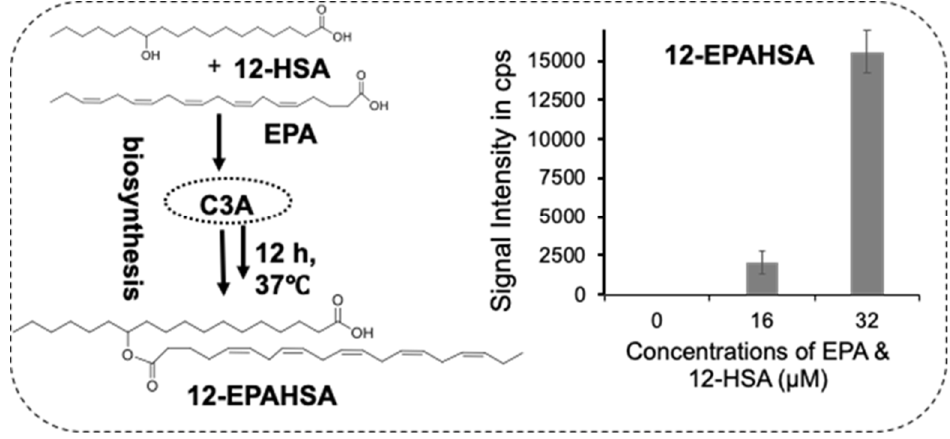
Figure 3. Biosynthesis of 12-EPAHSA in C3A cells spiked with concentrations of single components of the equimolar mixture of EPA and 12-HSA.